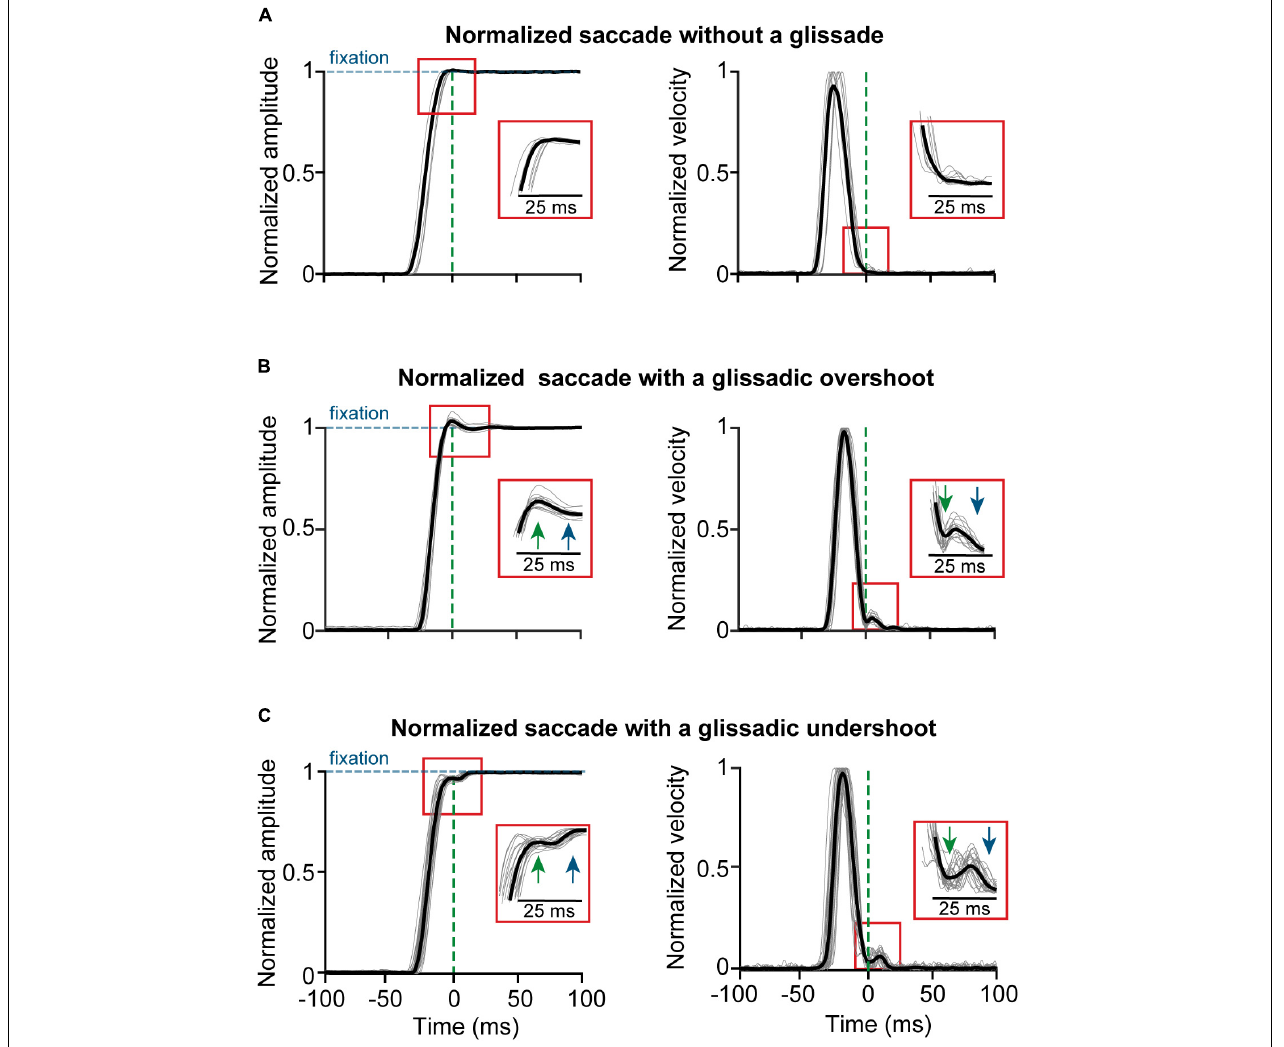
FIGURE 1 | Example traces of saccades normalized to fixation with and without the glissade. All saccades aligned to the onset of a glissade. (A) Position and velocity traces of saccade (gray) and average (black) of saccades without a glissade; 59% of all saccades. (B) Example traces of saccades with glissadic overshoot (35% of all saccades); inset shows glissade onset (green arrow) and offset (blue arrow). (C) Example traces of saccades with a glissadic undershoot (6% of all saccades). Percentages were calculated from 3597 saccades from 4 monkeys (data collected with a scleral search coil). Traces were normalized to prevent the glissades from being concealed by the variability in saccade